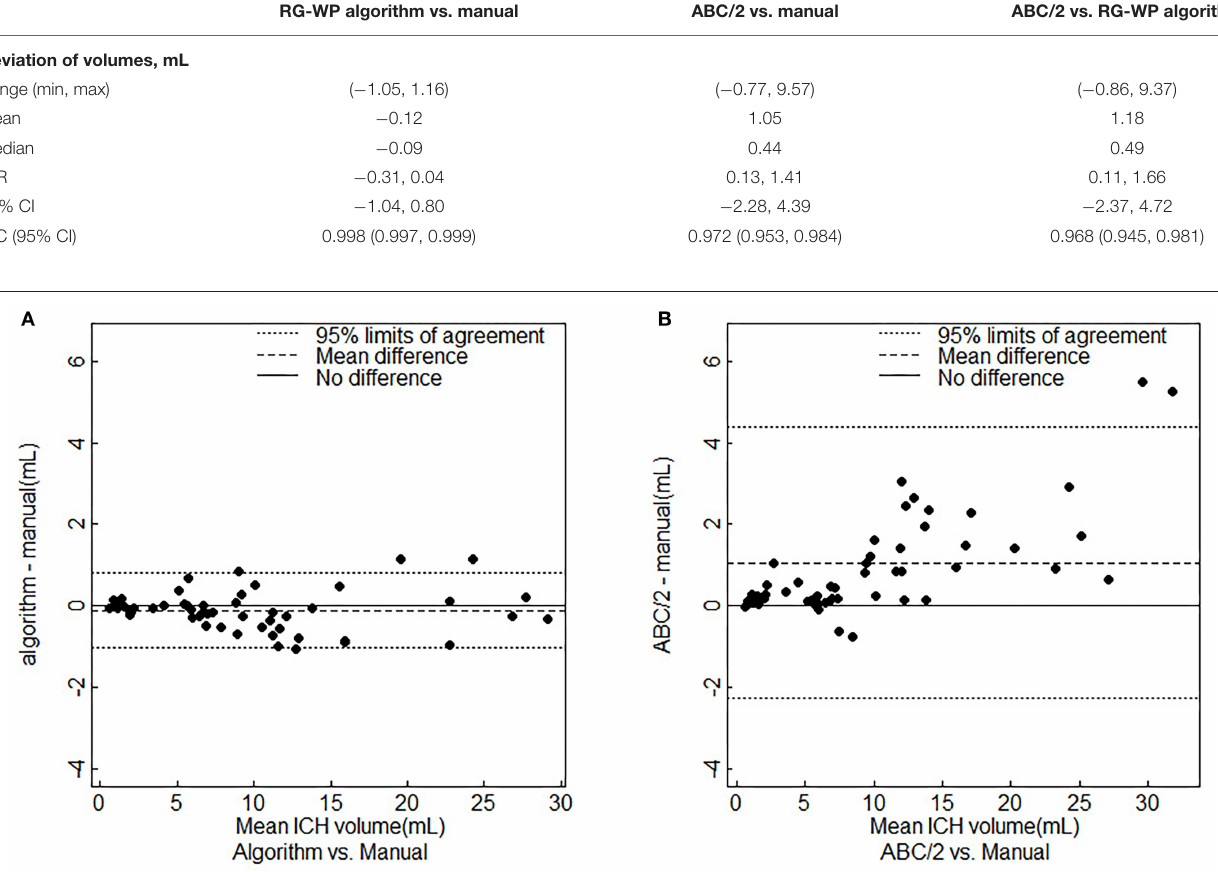
TABLE 2 | Segmentations comparison among the RG-WP algorithm, manual, and ABC/2. RG-WP algorithm vs. manual ABC/2 vs. manual ABC/2 vs. RG-WP algorithm